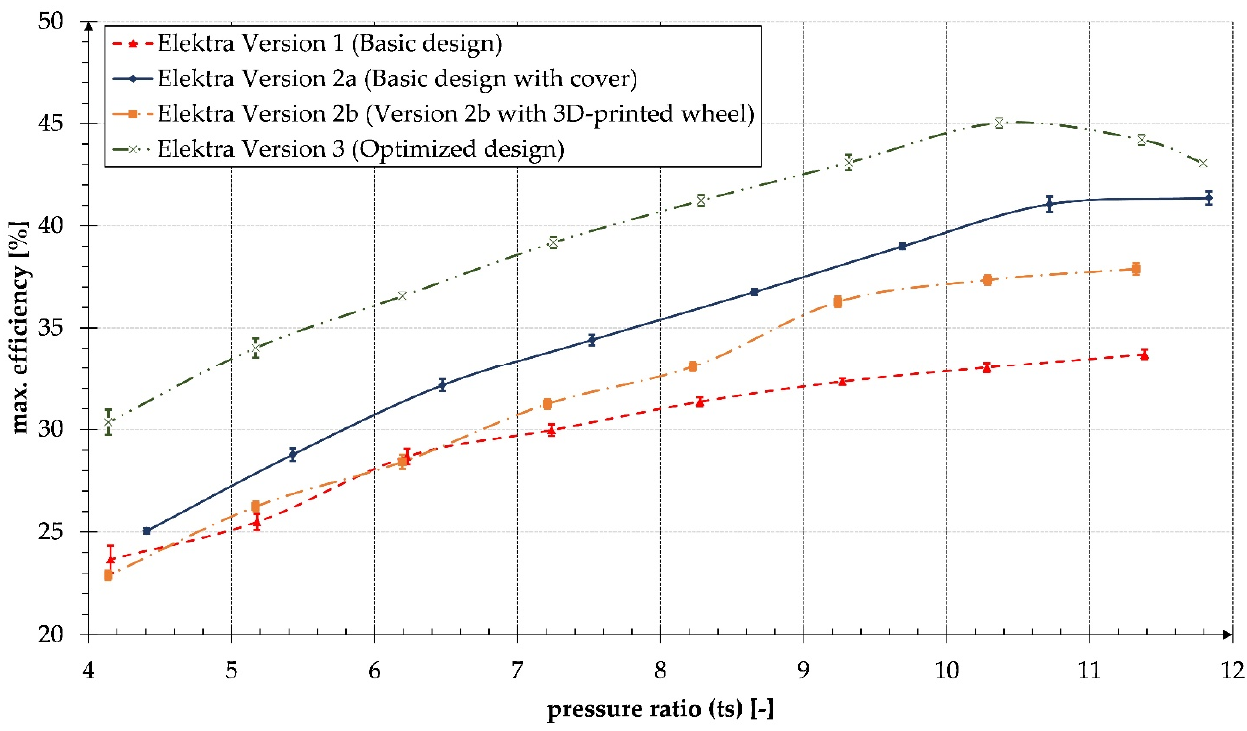
Figure 14. Efficiency curves of the final Elektra ( Version 3 ) for different rotational speeds and pres- sure ratios.